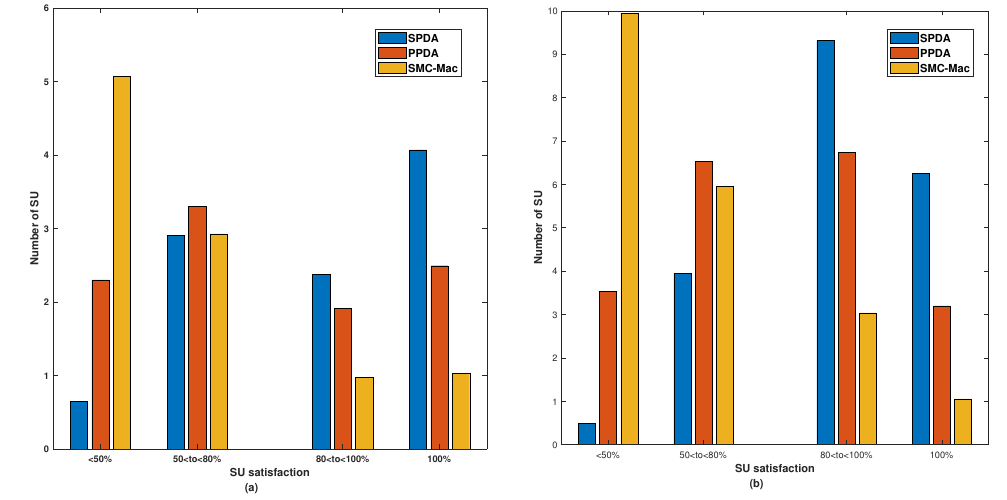
Figure 6. Number of SU at different level of SU satisfaction: ( a ) M = 10, ( b ) M =